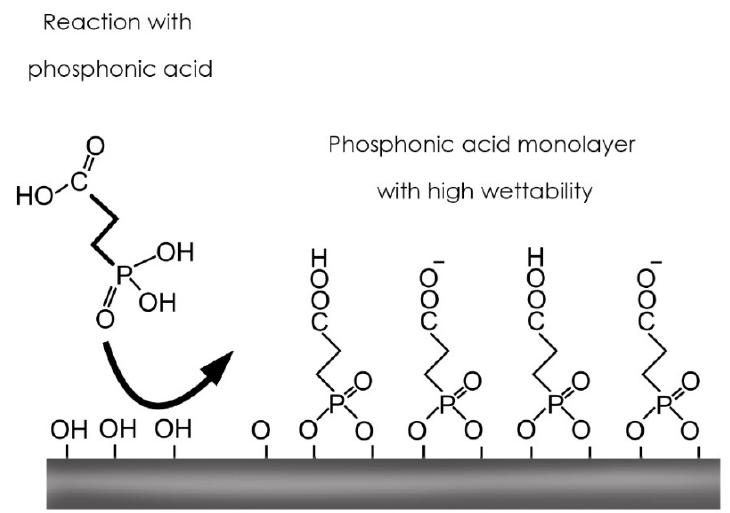
Figure 1. Scheme of the molecular reaction of carboxyethylphosphonic acid on the titanium surface. The black arrow indicates when carboxyethylphosphonic acid contacts and bonds to the OH groups of TiO 2 .